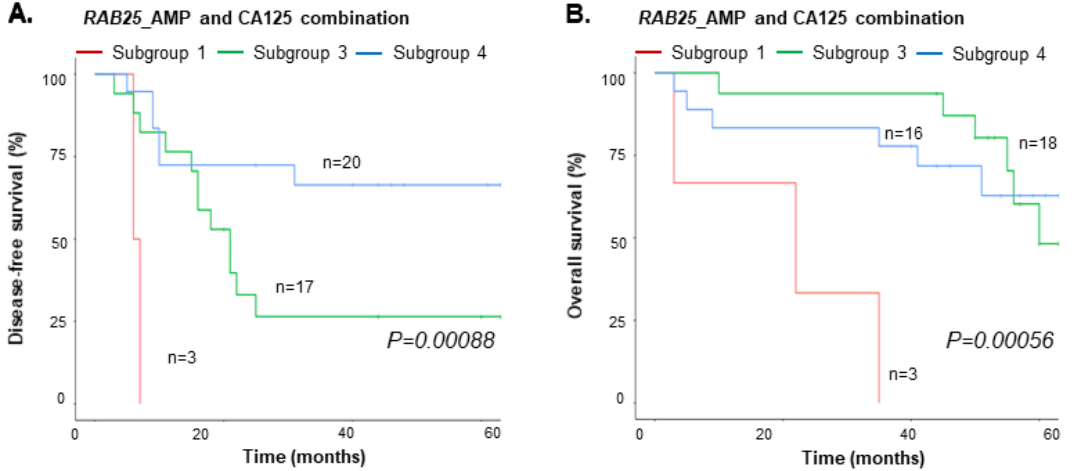
Figure 5. cfDNA and CA125 combination analysis. ( A ) DFS and ( B ) OS of EOC patients with RAB25 amplification and CA125.